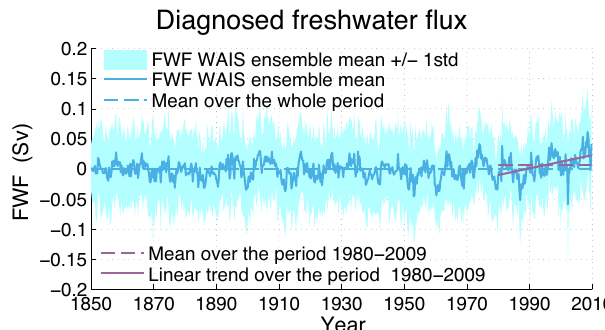
Figure 6. Freshwater flux from the model simulation with data as- similation and additional autoregressive freshwater flux following Eq. (1) (DA_FWF). The ensemble mean is shown as the blue solid line, surrounded by one standard deviation shown as the light blue shading. The dashed blue (purple) line shows the mean over the pe- riod 1850–2009 (1980–2009). The linear fit between 1980 and 2009 is shown as the solid purple